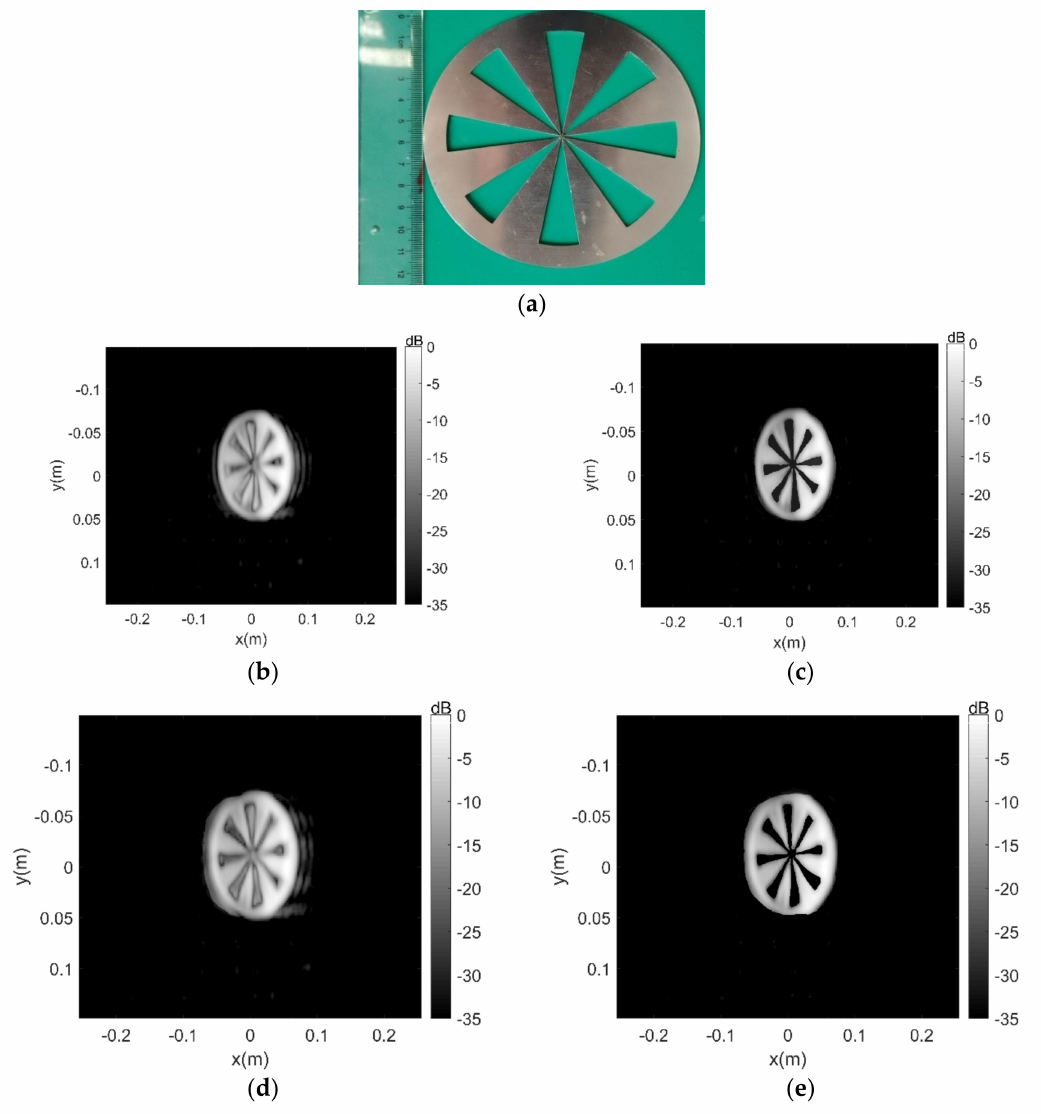
Figure 14. The experimental results. ( a ) Optical picture of targets. ( b , c ) are the results of BPA and CF-BPA. ( d , e ) are the are the results of the PSM algorithm and the MCF-PSM